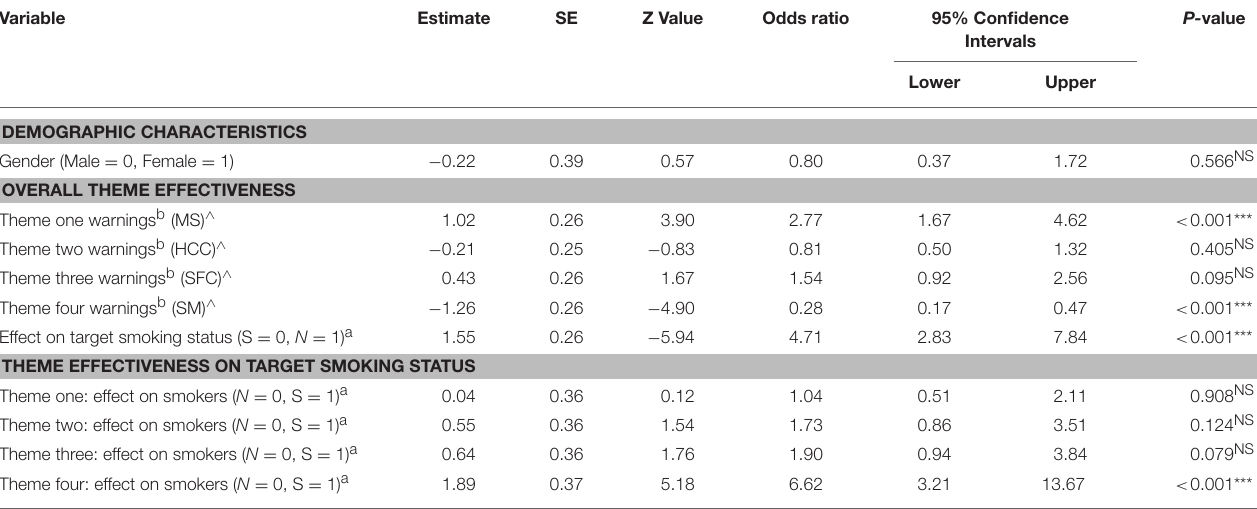
P- value Intervals Lower Upper